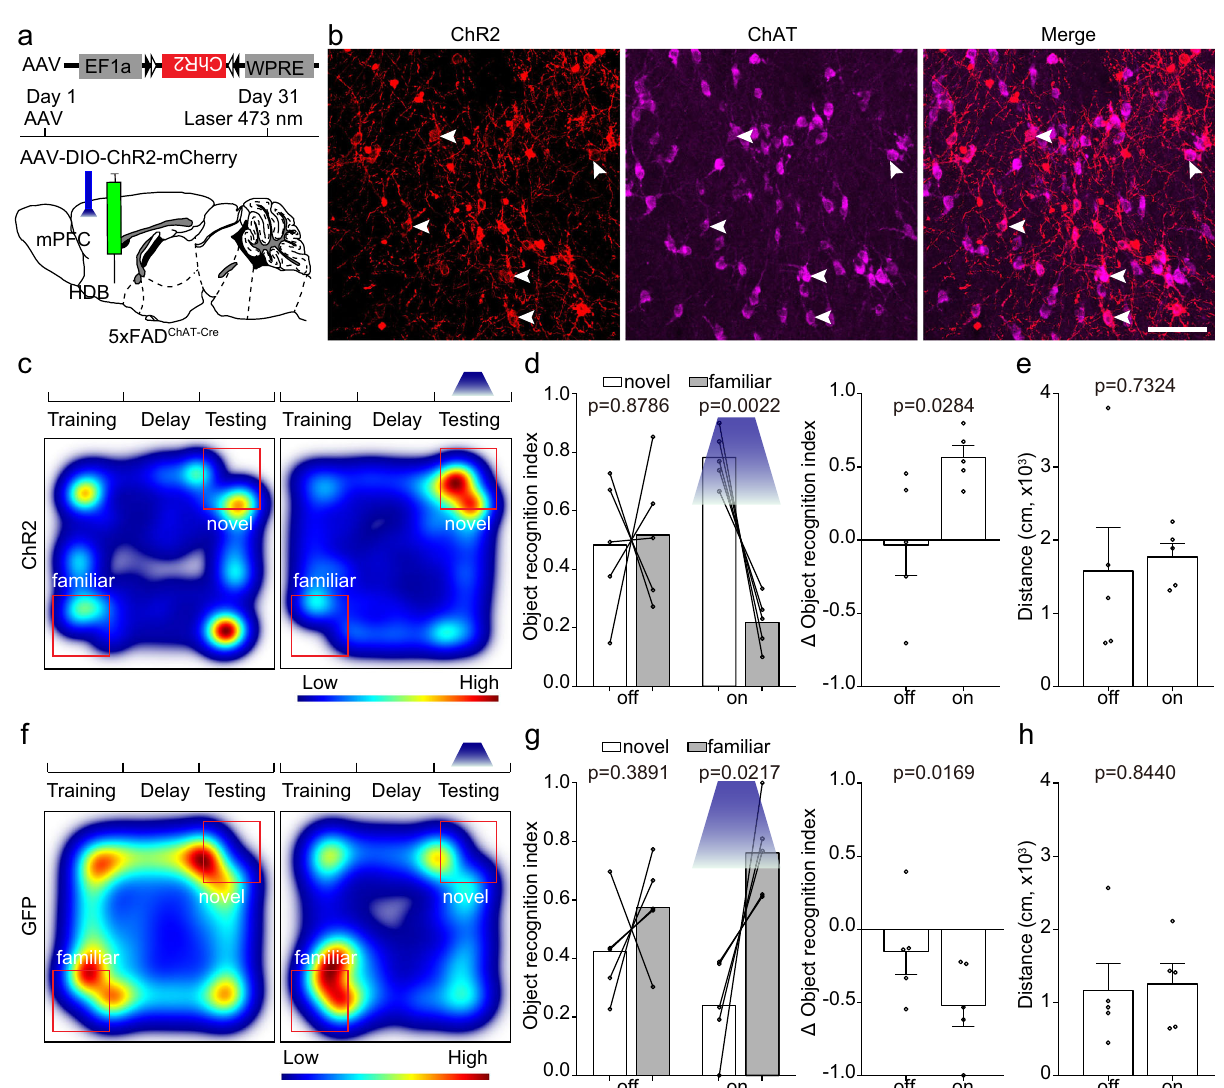
Fig. 7 Activation of cholinergic axon terminals in the mPFC of 5×FAD mice improved object recognition memory expression. a The experimental strategy of activation of cholinergic terminals in the mPFC. b Immunostaining against ChAT to validate the speci fi city of the AAV. c Heat-map plots showed object recognition memory measures from the object recognition test. Red = more time, blue = less time. The heatmap in the left and right showed examples of AD ChAT-Cre mice that expressed ChR2 in the cholinergic terminals in the mPFC exploring the familiar object and novel object during test session without or with light stimulation, respectively. d Statistical plots of object recognition index and delta object recognition index in laser off and laser on sessions. (left and right, two-tailed paired t test). n = 5 animals. e The statistical plot showed the traveling distance of AD ChAT-Cre mice with or without light activation of the cholinergic terminals in the mPFC. two-tailed paired t test, n = 5 animals. f The heatmap in the left and right showed examples of AD ChAT-Cre mice that expressed GFP in the cholinergic terminals in the mPFC exploring the familiar object and novel object during test session without or with light stimulation, respectively. g Statistical plots of object recognition index and delta object recognition index in laser off and laser on sessions. (left and right, two-tailed paired t test). n = 5 animals. h Statistical plots showed the traveling distance in GFP group with or without light stimulation. two-tailed paired t test, n = 5 animals. Scale bar in b is 50 μ m. All data are listed as the Mean ±